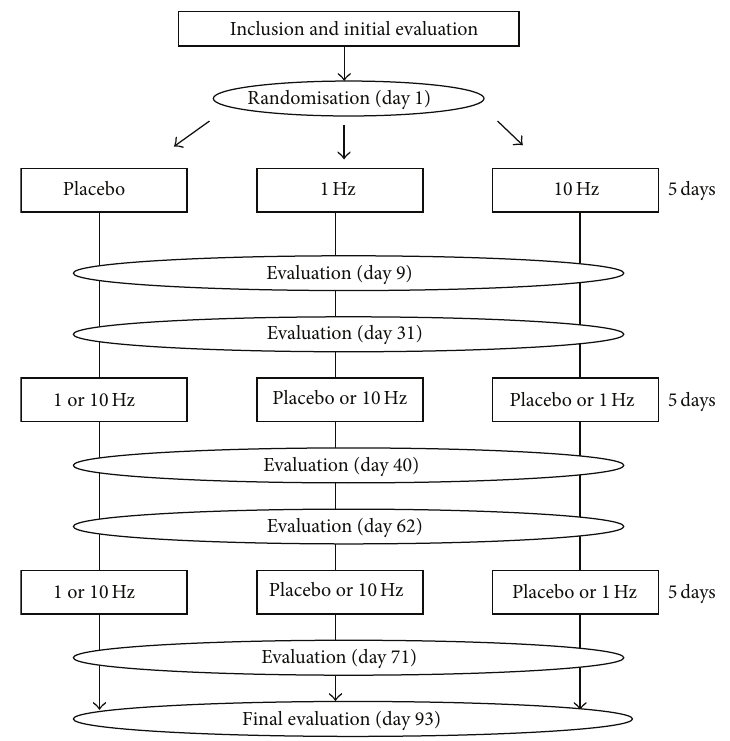
Figure 1: Design of the